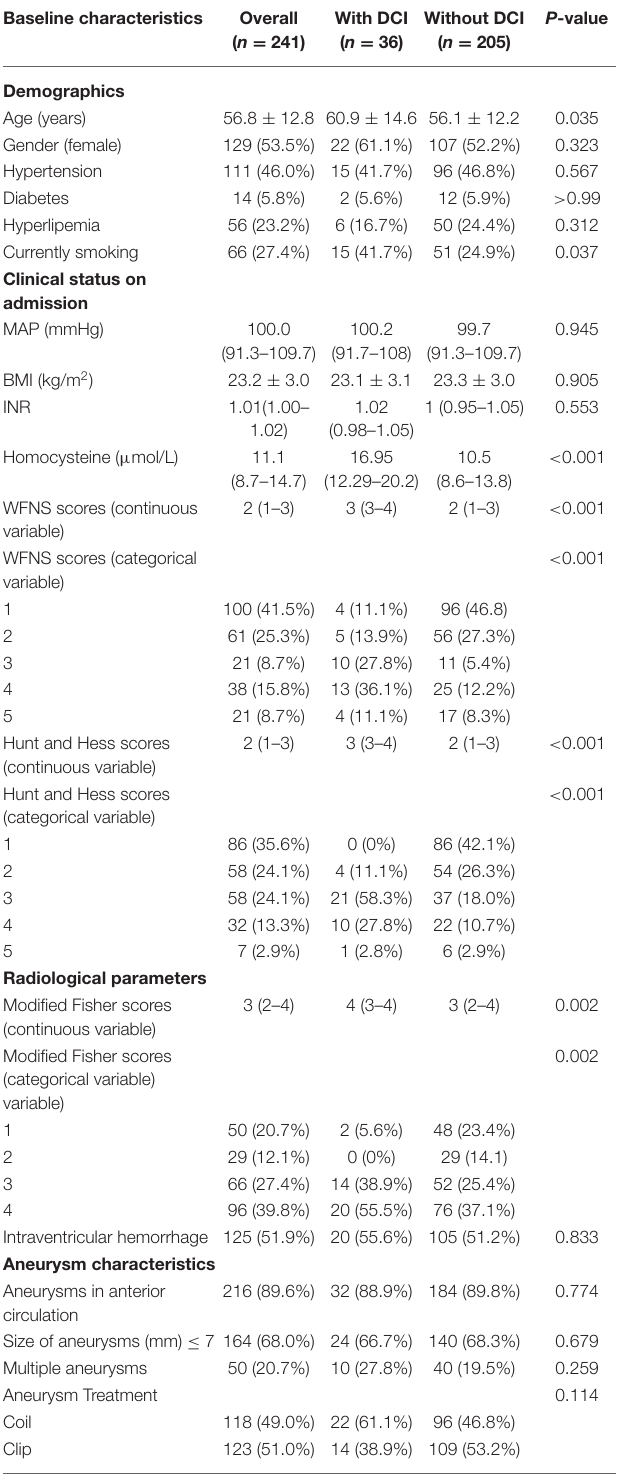
TABLE 1 | The demographic and clinical data in patients with aneurysmal subarachnoid hemorrhage. Baseline characteristics